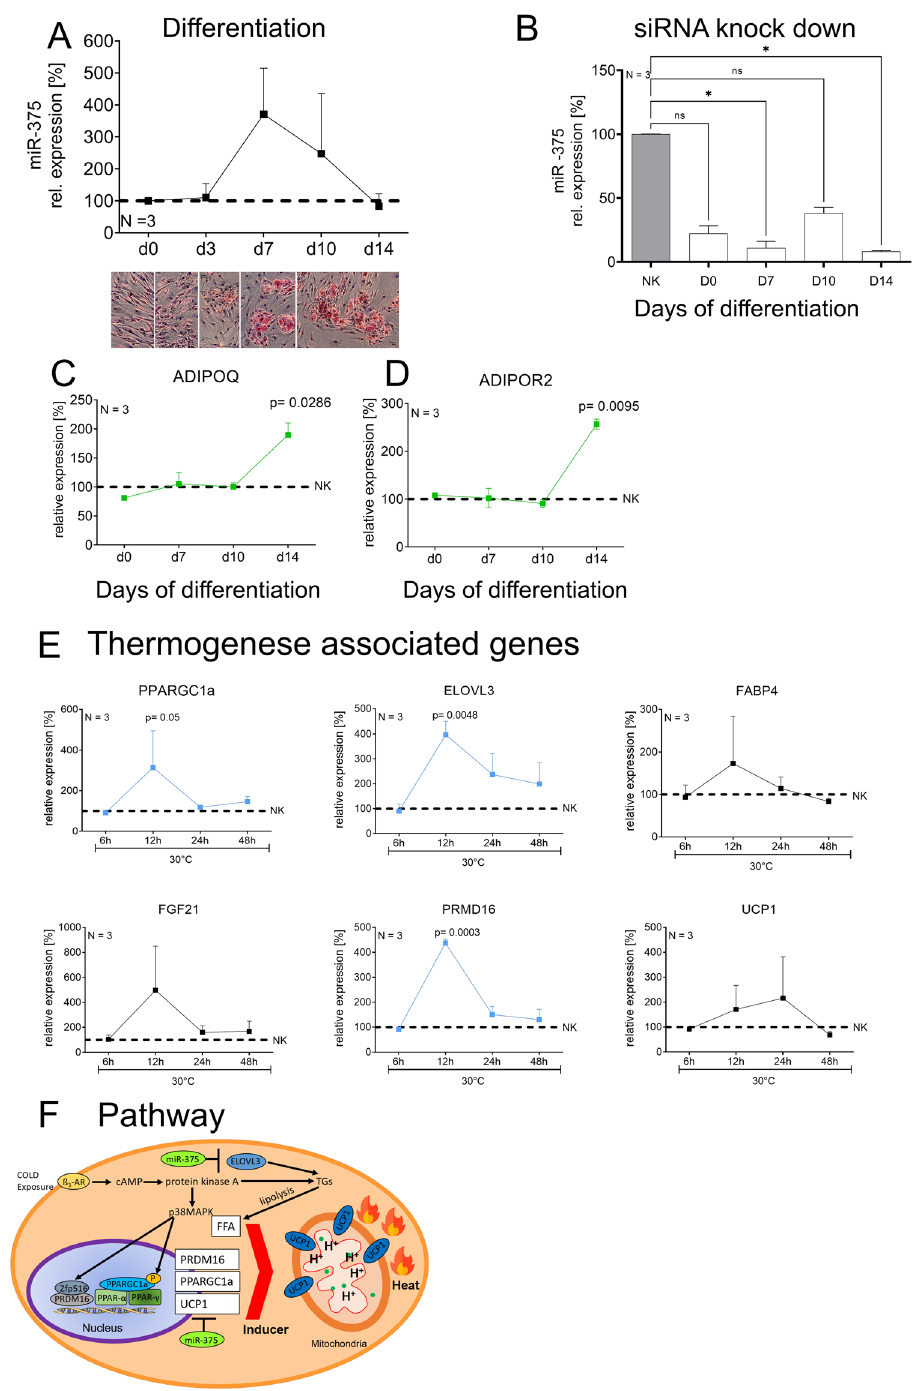
Figure 3. Depletion of miR-375 in VC-PACs led to increased thermogenesis genes under cold stimulation. ( A ) Relative miR-375 gene expression over the differentiation period in VC-PACs. Corresponding Oil Red O staining is displayed below. ( B ) siRNA knock down of miR-375 at day 0, 7, 10 and day 14 of adipogenic differentiation of VC-PACs. ( C, D ) Depletion of miR-375 elevated ADIPOQ and ADIPOR2 gene expression in fully differentiated VC-PACs. ( E ) Corresponding gene analyses showed significant changes of PPARGC1A, ELOVL3 and PRDM16 i n cold stimulated miR-375 knock down cells of VC adipose tissue. ( F ) Associated adipogenic/beiging pathway influenced by miR-375. Data are normalized to relevant housekeeping genes and shown as mean ± SEM. Statistical significance were defined as follows: ** P < 0.01 , *** P < 0.001 . SC = subcutaneous, VC =